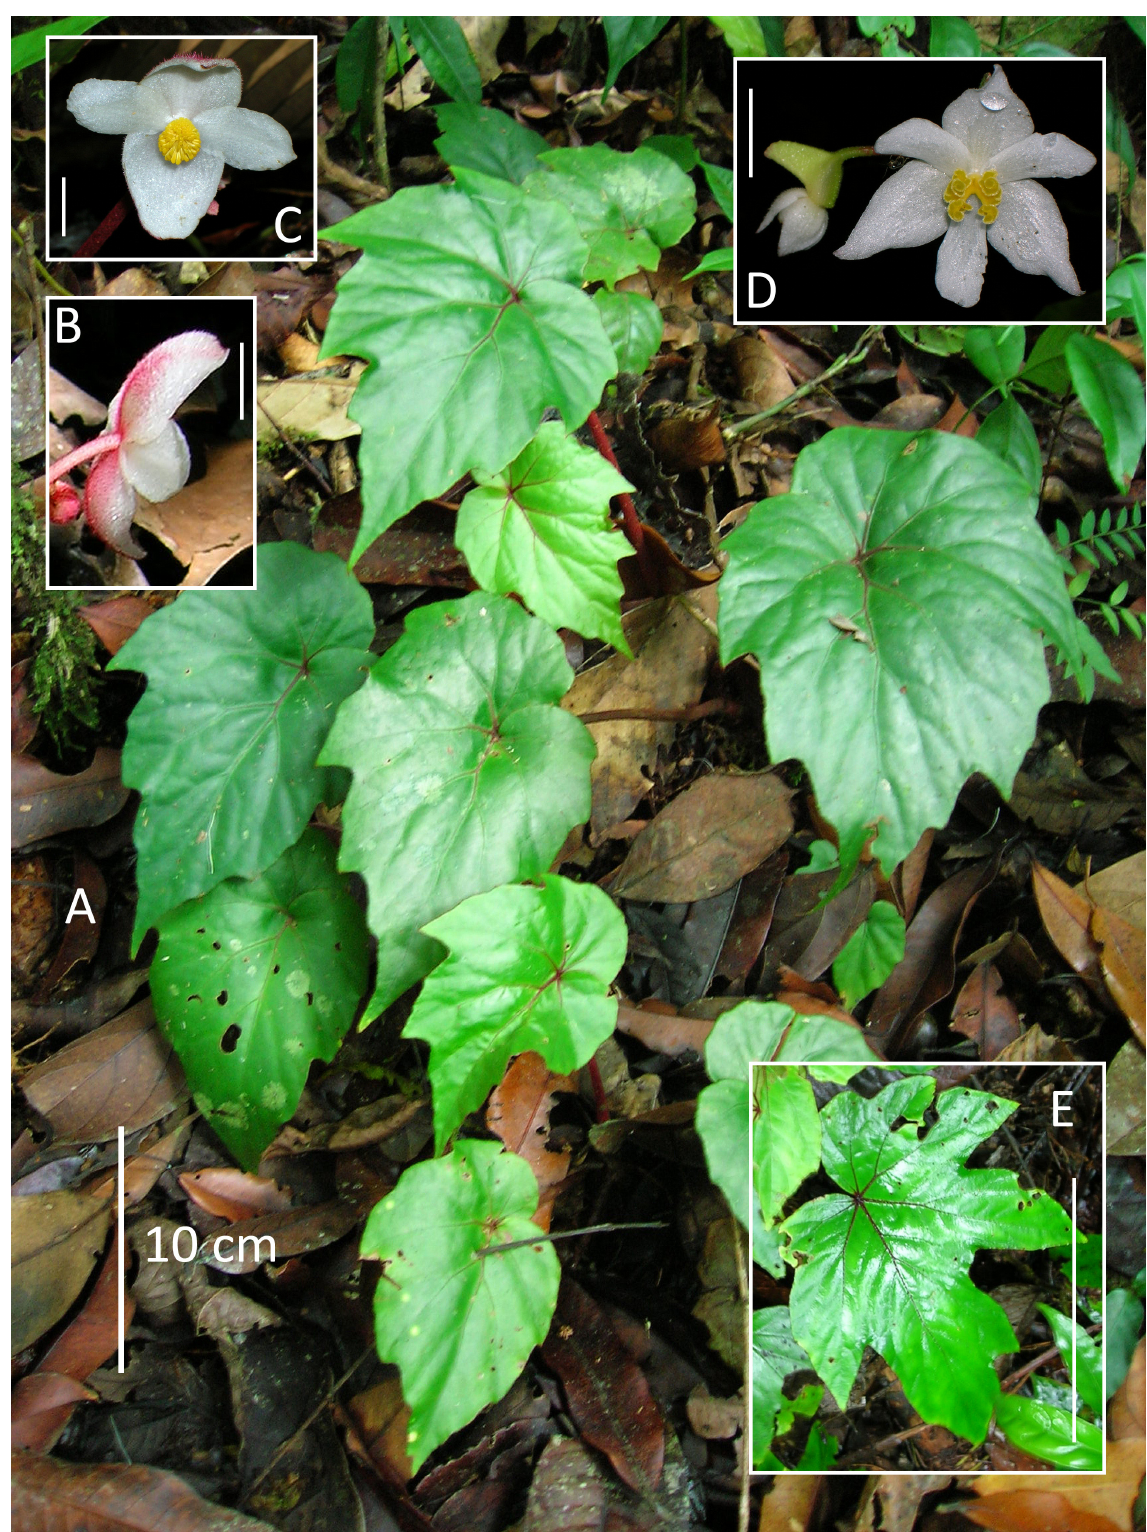
Fig. 12. Begonia leuserensis M.Hughes sp. nov. A . Habit. B . Male flower back view. C . Male flower. D . Female flower. E . Lobed leaf. A–D from Air Panas of the type collection Wilkie et al. PW791 ; E from PW778 . Scale bars on insets: B–D = 1 cm; E = 10